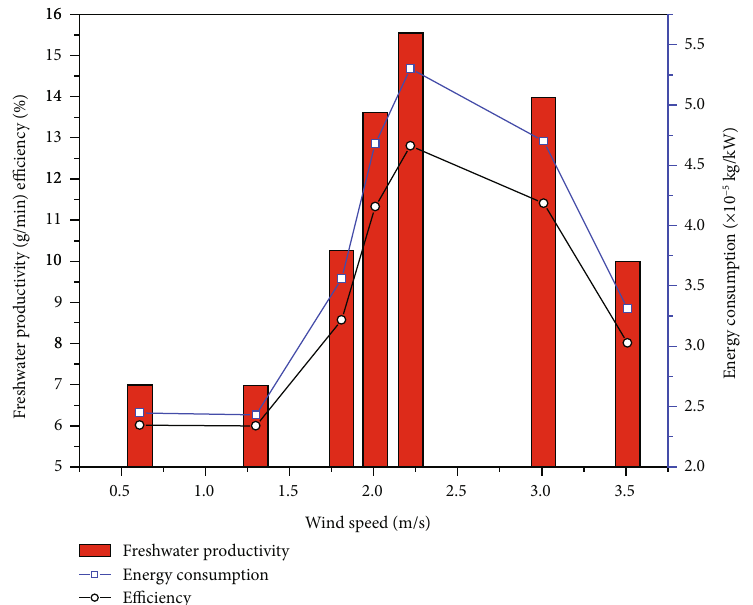
Figure 7: Freshwater productivities, thermal e ffi ciencies, and energy consumption under di ff erent inlet wind speeds when the ambient relative humidity is